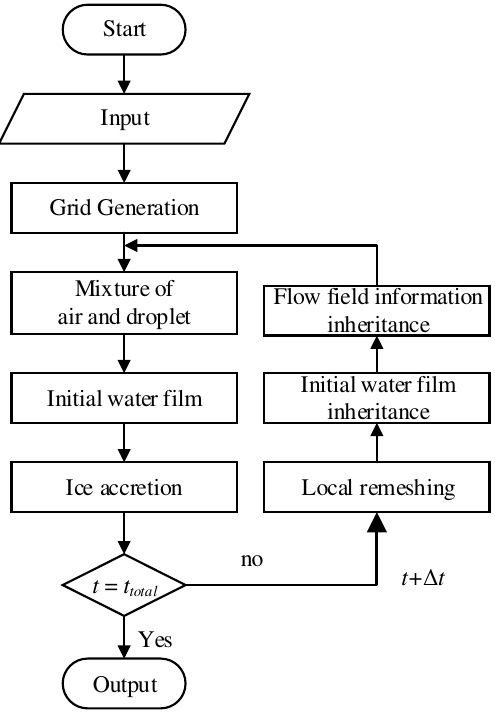
Figure 2. Framework for the unsteady icing